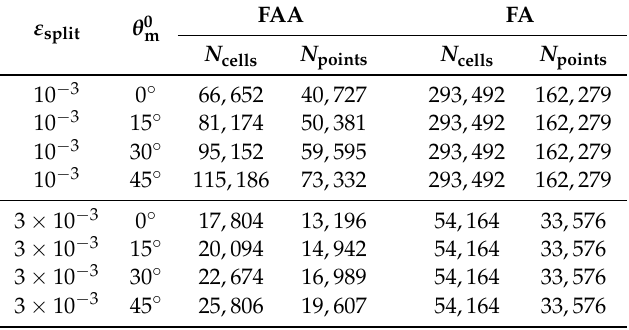
Table 6. The first part of the table shows the number of adaptive cells N cells and the final number of grid points N points for computing the derivatives ∂ I / ∂σ ext p with the splitting accuracy ε split = 10 − 3 , while the second part of the table shows N cells and N points for computing the derivatives ∂ I / ∂σ max ext and ∂ I / ∂ X with the splitting accuracy ε split = 3 × 10 − 3 . The results correspond to the linearized forward-adjoint approach (FAA) and the linearized forward approach (FA). FAA FA ε split θ 0 m N cells N points N cells N points 10 − 3 0 ◦ 66,652 40,727 293,492 162,279 10 − 3 15 ◦ 81,174 50,381 293,492 162,279 10 − 3 162,279 162,279 0 ◦ 17,804